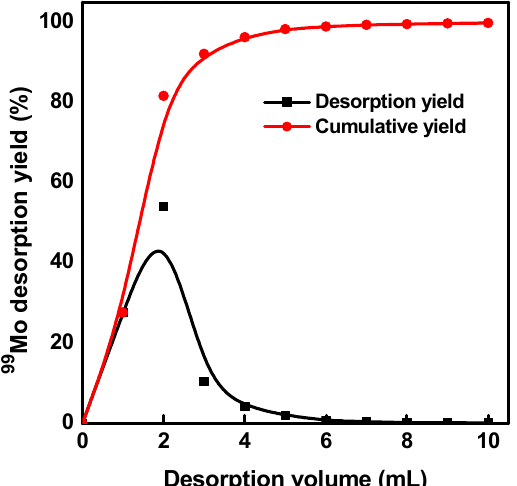
Figure 8. Desorption profile of 99 Mo from the spent generator